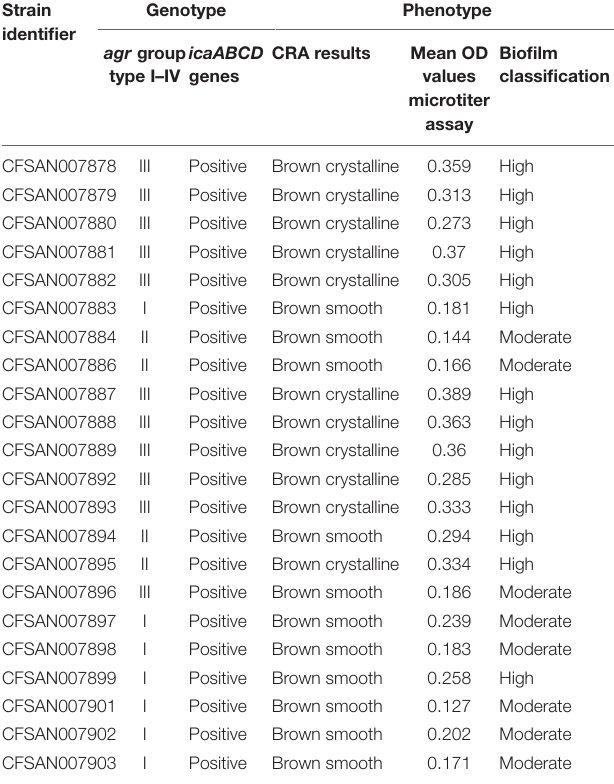
TABLE 3 | Genotypic identification of agr groups and icaABCD genes along with phenotypic classification of biofilm formation using CRA and microtiter plate assays for the S. aureus outbreak recovered